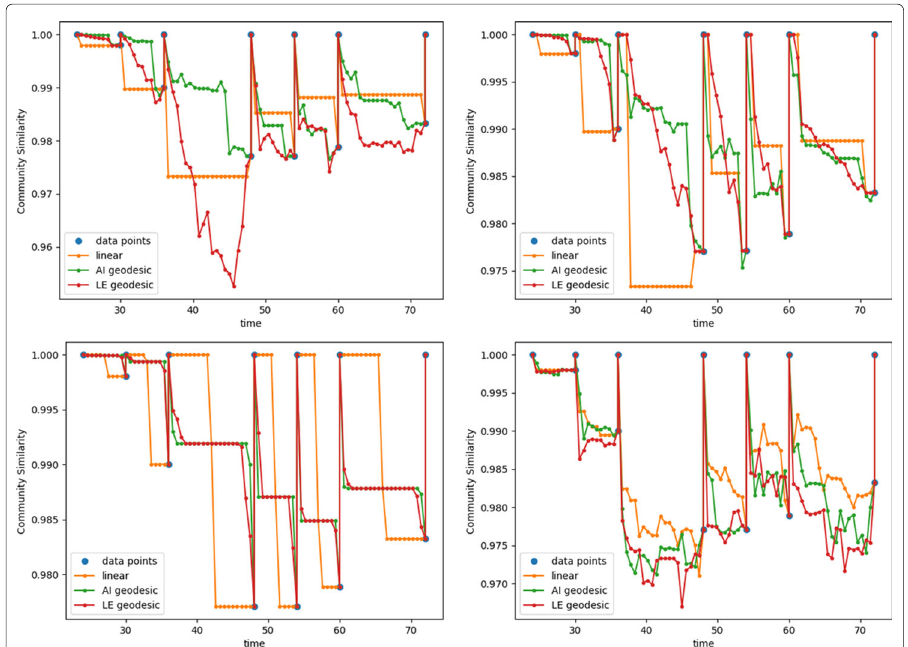
Fig. 10 Community similarity in interpolated proteomics network. When no threshold is applied ( bottom right ), the LE geodesic displays more extreme behaviour than the AI geodesic. A threshold of 0.1 ( topright ) gives the best performance for the geodesics, a threshold of 0.02 ( topleft ) produces excessive variation in the LE geodesic, and a threshold of 0.5 ( bottomleft ) produces almost piecewise constant behaviour in the geodesics. The linear interpolation produces reasonable results when no threshold is